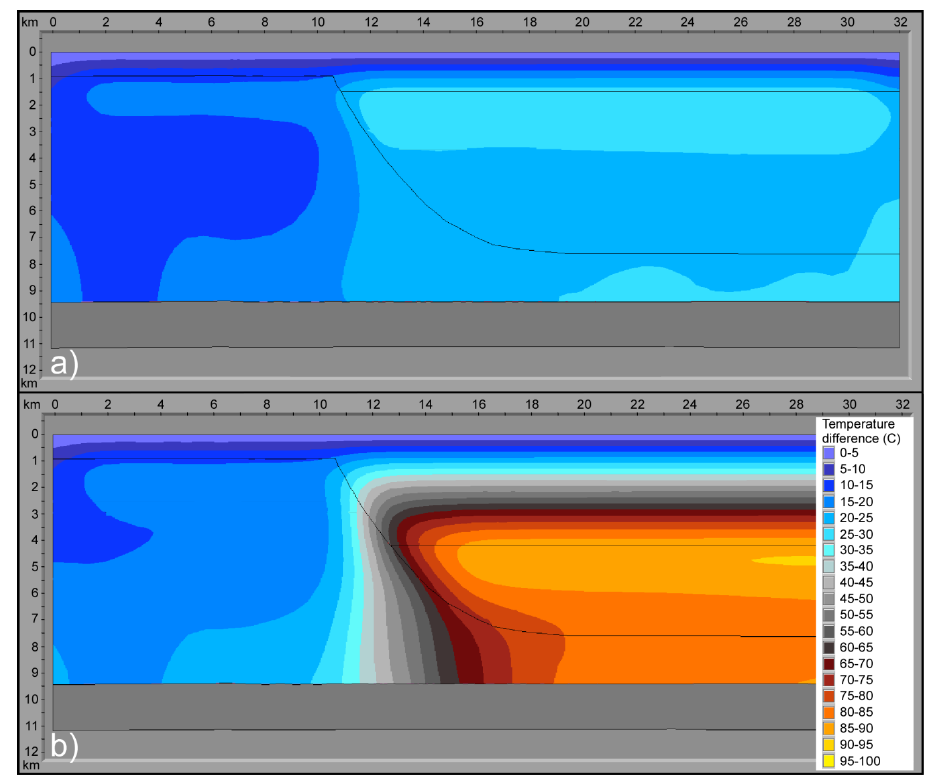
Figure 7. Temperature difference between steady state and transient temperatures for fault slip of 500 m ( a ) and 3000 m ( b ) at 10 kyr after fault slip.